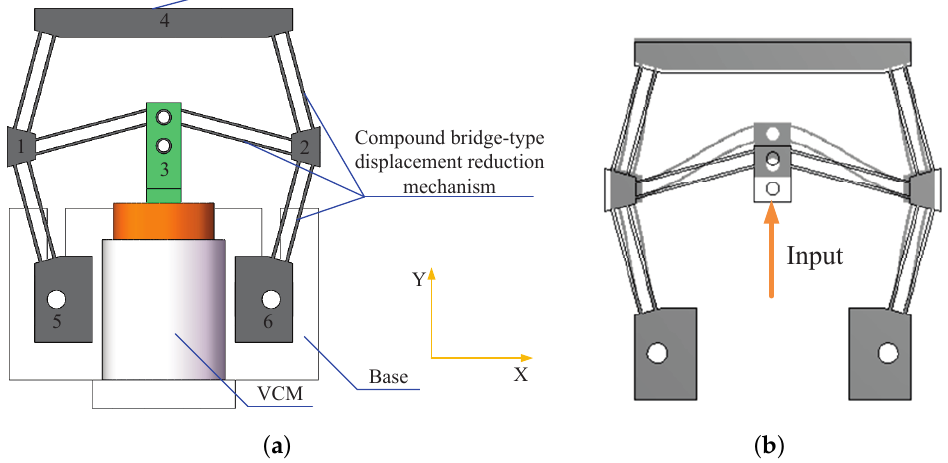
Figure 1. Flexure-based displacement reduction mechanism. ( a ) Structure of the mechanism. ( b ) Working principle of the